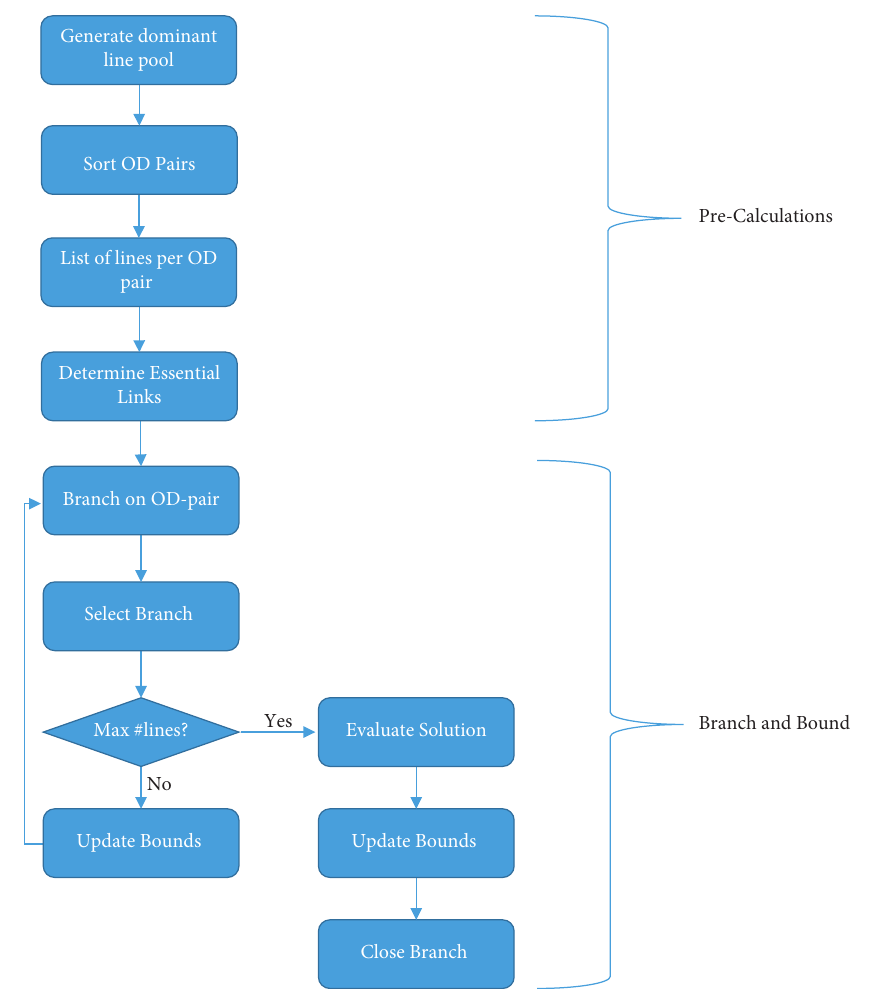
Figure 5: Flowchart of the